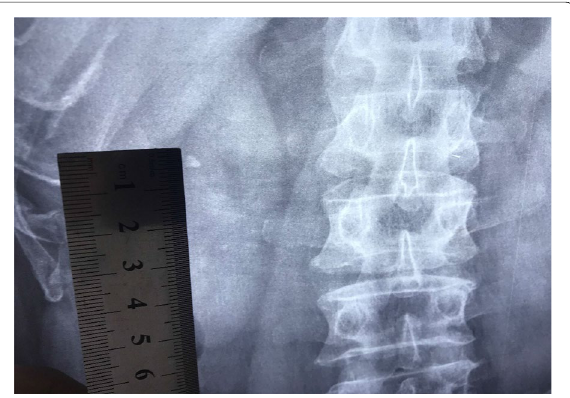
Fig. 2 KUB radiograph, small opaque stone